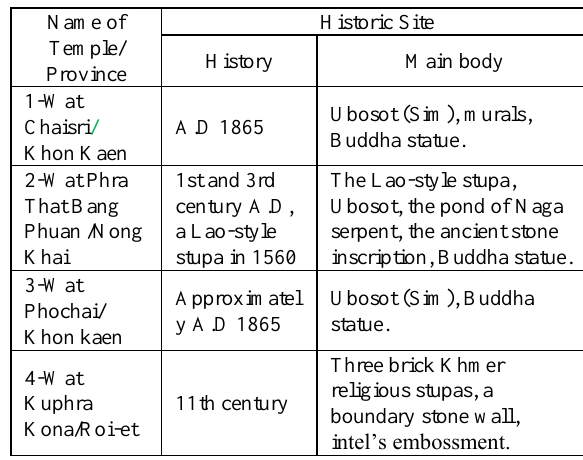
Table 1. The existence of the local temple with a historic site or historic building.